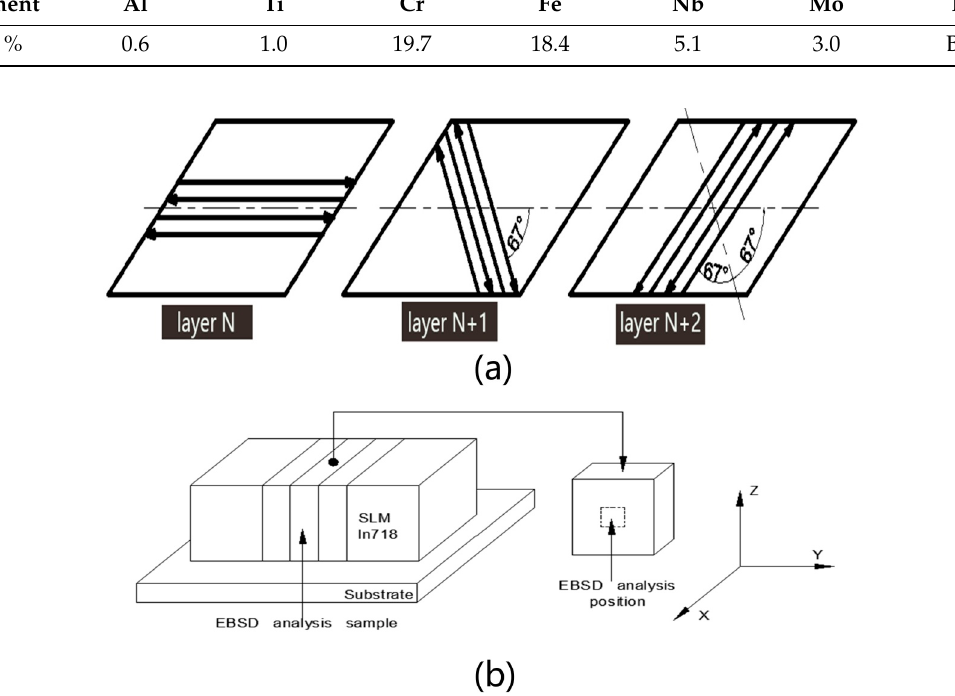
Figure 1. ( a ) Scanning strategy sketch map. ( b ) Sketch map of sample cutting and electron backscatter diffraction (EBSD) analysis sections (Z direction is the building direction).